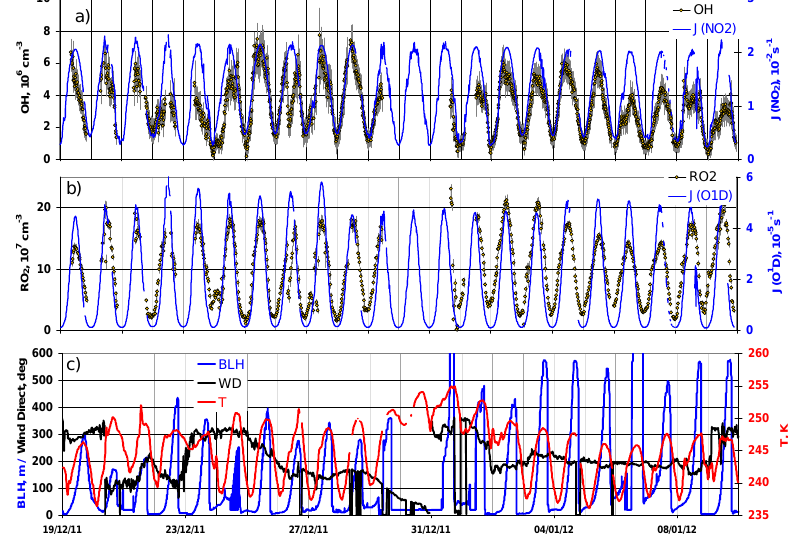
Figure 1. Temporal profiles at Dome C: [OH], J (NO 2 ) (a) ; [RO 2 ], J (O 1 D) (b) ; wind direction, temperature and modelled boundary layer height (BLH) (c)